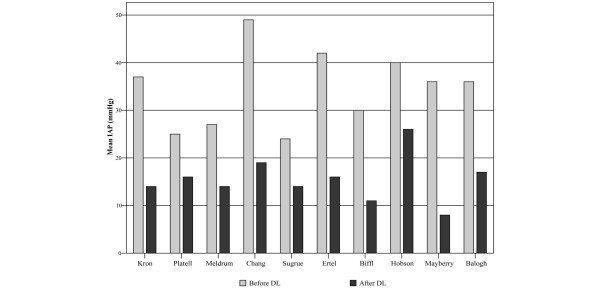
The effect of decompressive laparotomy (DL) on intraabdominal pressure (IAP) in patients with primary and secondary abdominal compartment syndrome. IAP levels are those reported in individual papers in the study; Kron and colleagues [23], Platell and colleagues [26], Meldrum and colleagues [17], Chang and colleagues [28], Sugrue and colleagues [18], Ertel and colleagues [2], Biffl and colleagues [32], Hobson and colleagues [16], Mayberry and colleagues [34], Balogh and colleagues [35].